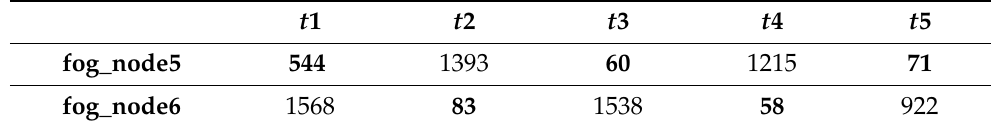
Table 1. Ping duration values reported by User agent on fog_node3 (ms).